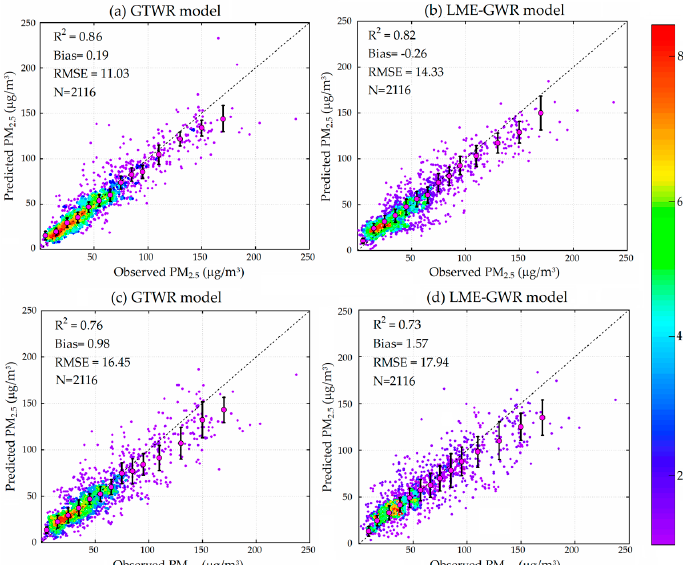
Figure 7. Density scatterplots of modelled vs. ground-based observations of PM 2.5 concentrations for